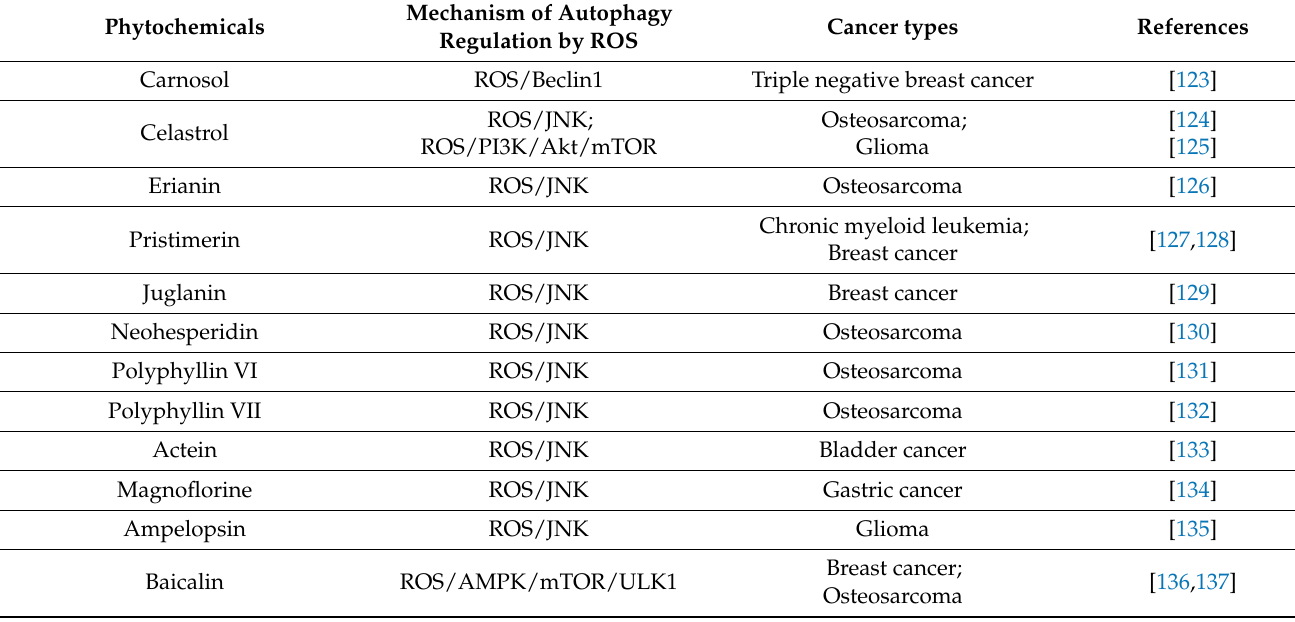
Table 1. Mechanisms of action of phytochemicals that can regulate autophagy and ROS.